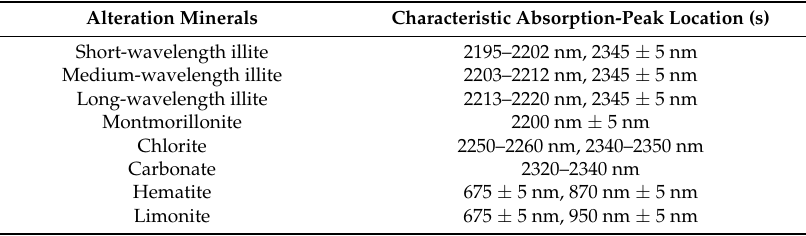
Table 3. Absorption features of the eight investigated alteration